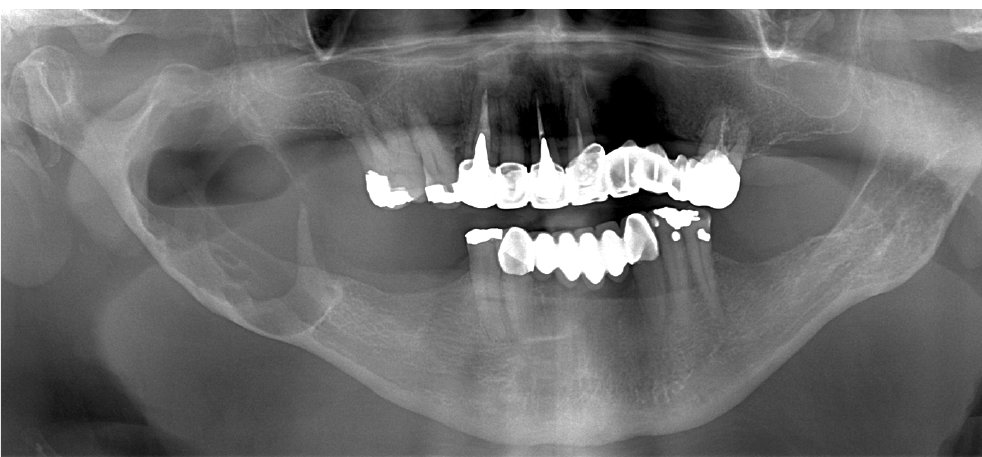
Fig. 1. Large odontogenic keratocyst of the right mandibular angle.